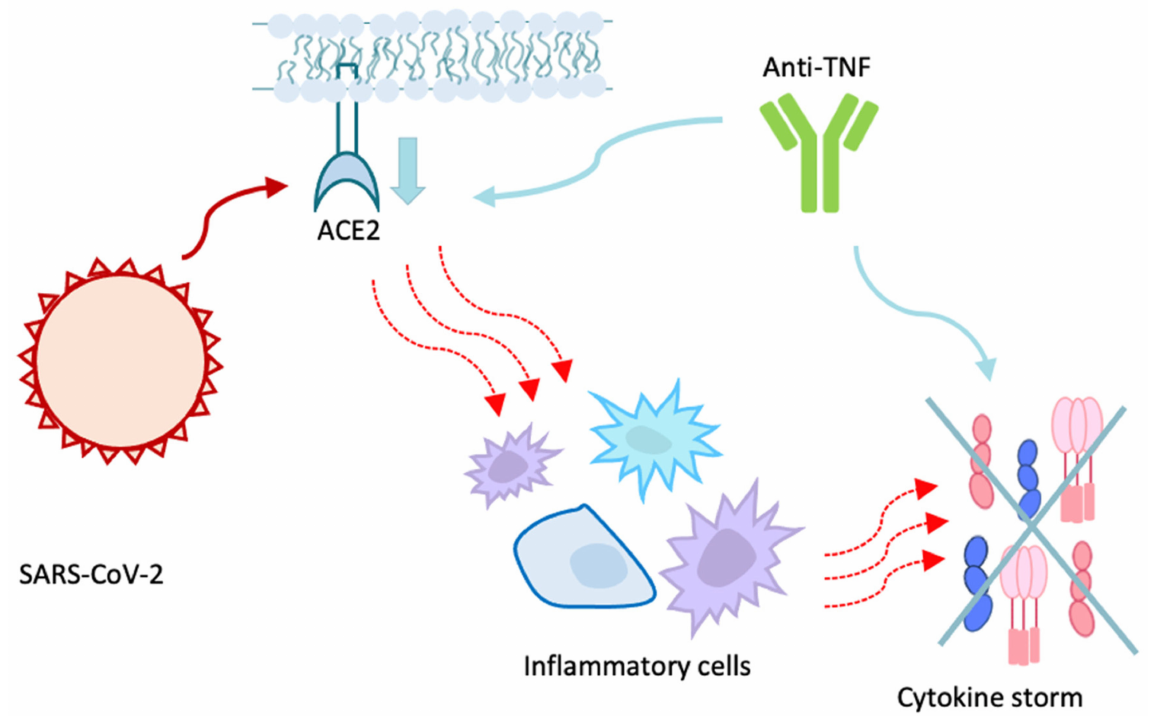
Figure 4. The potential protective role of anti-TNFs against COVID-19 is synthetically explained in this figure. Anti-TNFs have been shown to downregulate ACE2, leading to a most difficult virus entry into the cells. These drugs also have an anti-IL-6 activity, and this could contribute to the dampening of cytokine storm which is activated in most severe forms of COVID-19. ACE2: angiotensin converting enzyme 2. TNF: tumor necrosis